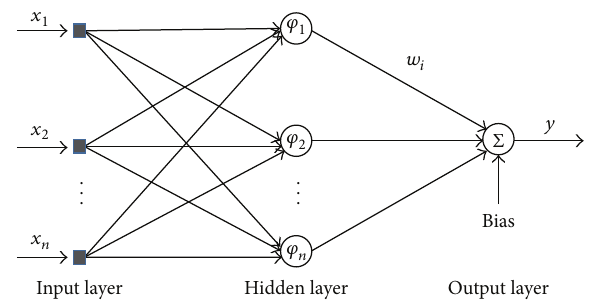
Figure 1: Architecture of the radial basis function neural